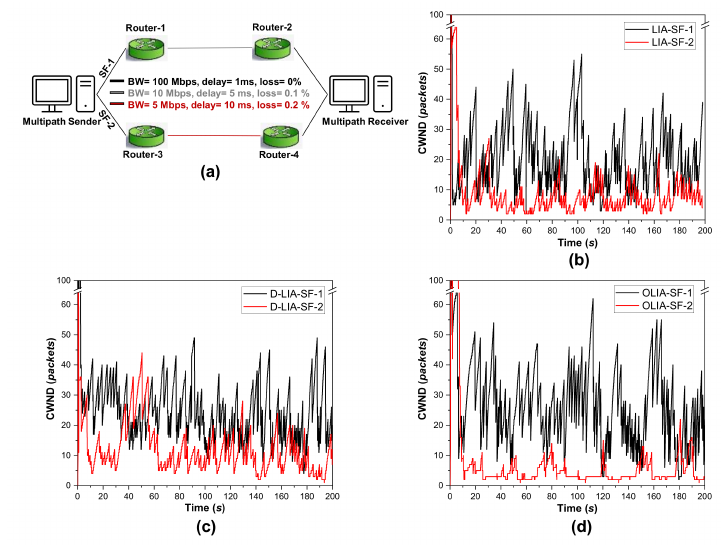
Figure 1. Simple experiment for observing the CWND changes for various MPTCP-CCAs: ( a ) the experimental scenario ( b – d ) when the applied MPTCP-CCA is LIA, D-LIA, and OLIA,